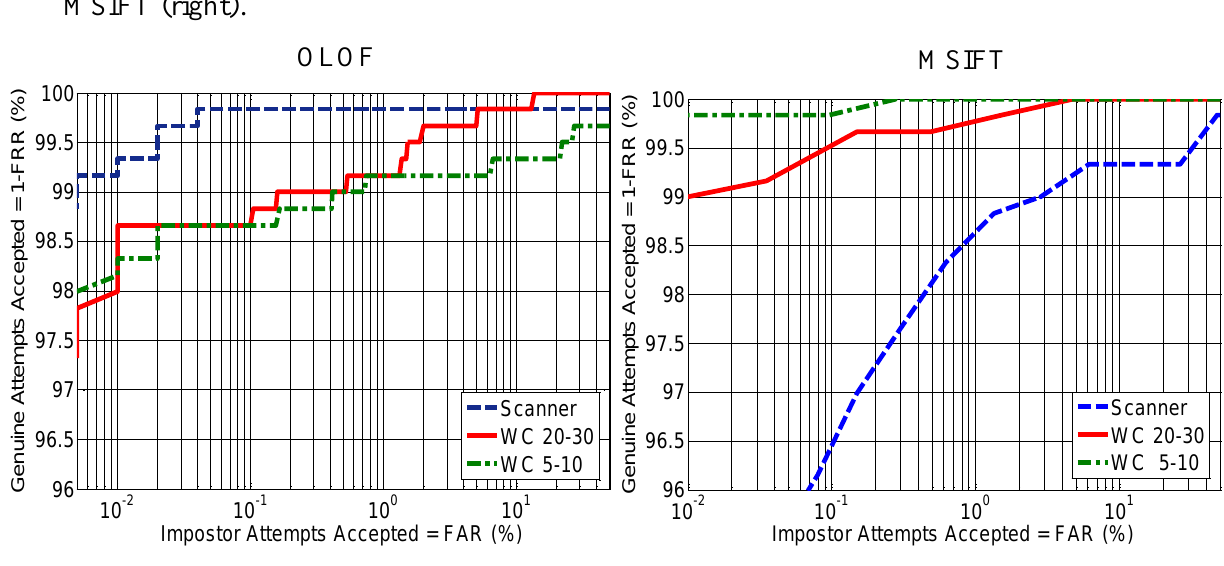
Figure 18. ROC curves for palm print features extraction methods, OLOF (left) and MSIFT